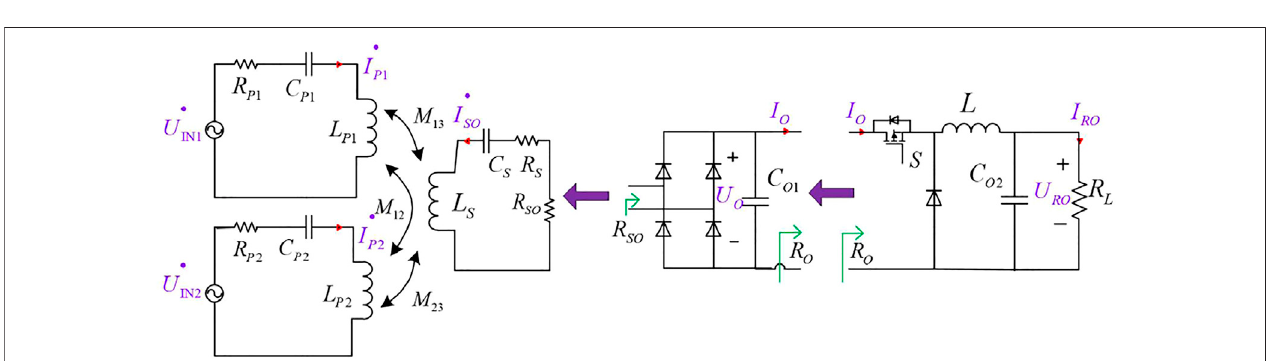
FIGURE 4 | Equivalent circuit model of the proposed